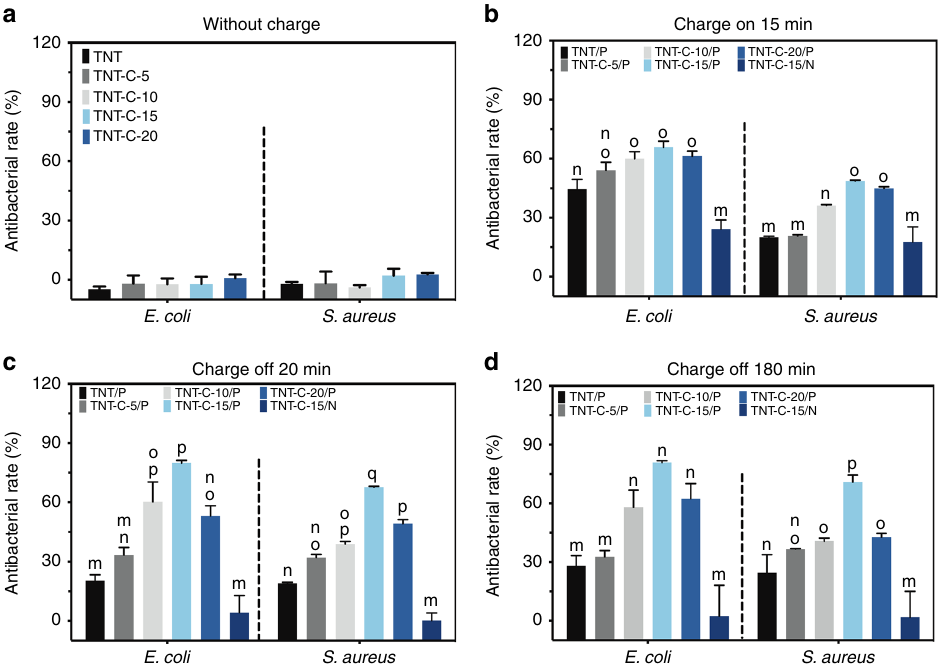
Fig. 3 Antibacterial effects under different conditions. a , b Antibacterial rates of various samples a without charging and b during DC charging for 15 min. c , d Post-charging antibacterial rates of charged samples after c 20 min and d 180 min of bacteria incubation. All error bars = standard deviation ( n = 3). P denotes DC + charging and N denotes DC – charging. Signi fi cant differences between groups are marked with different letters (m – q, P < 0.05, SNK test in